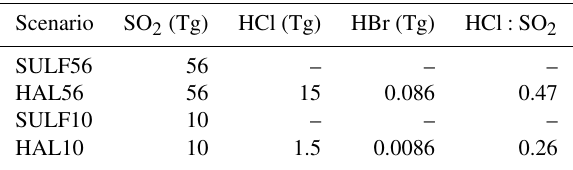
Table 1. Showing the eruption masses of SO 2 , HCl, and HBr in Tg for the four sets of